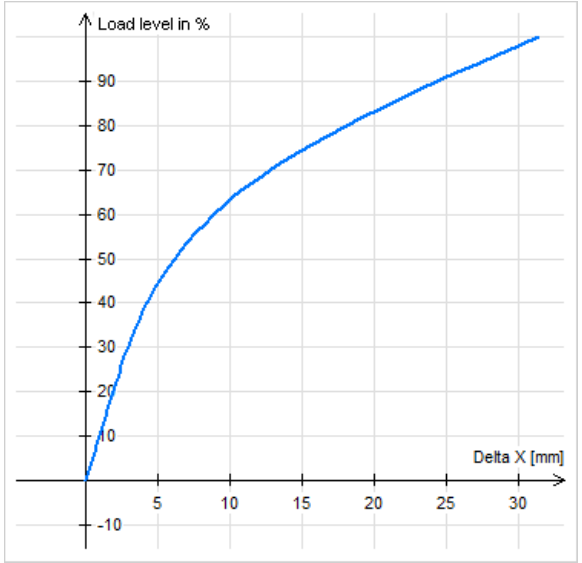
Figure 15. Capacity curve of the model with rigid beams.